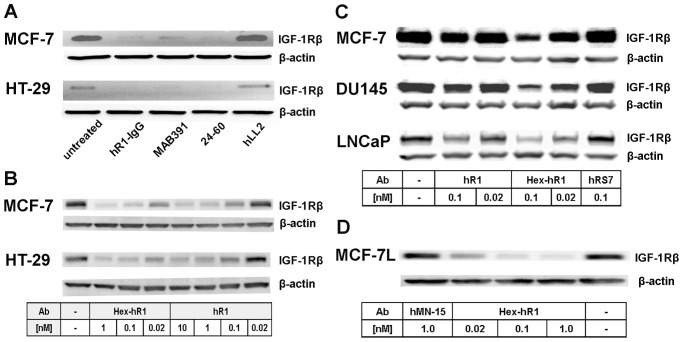
Downregulation of IGF-1R revealed with Western blot analysis of IGF-1Rβ in (A) MCF7 and HT-29 cells treated with hR1, MAB391, 24–60, and hLL2;
(B) MCF7 and HT-29 cells treated with hR1 or Hex-hR1; (C) MCF7, DU 145, and LNCaP cells treated with hR1, Hex-hR1, or hRS7 (irrelevant IgG); (D) MCF-7L cells treated with Hex-hR1 or hMN-15 (irrelevant IgG). In all experiments, β-Actin was used as a loading control.